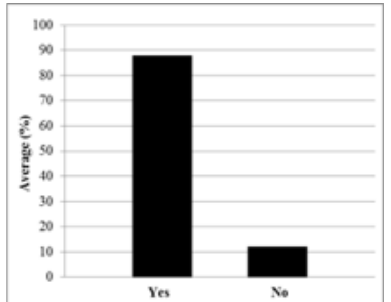
Figure 11. Responses from the Titration experimental group on whether they